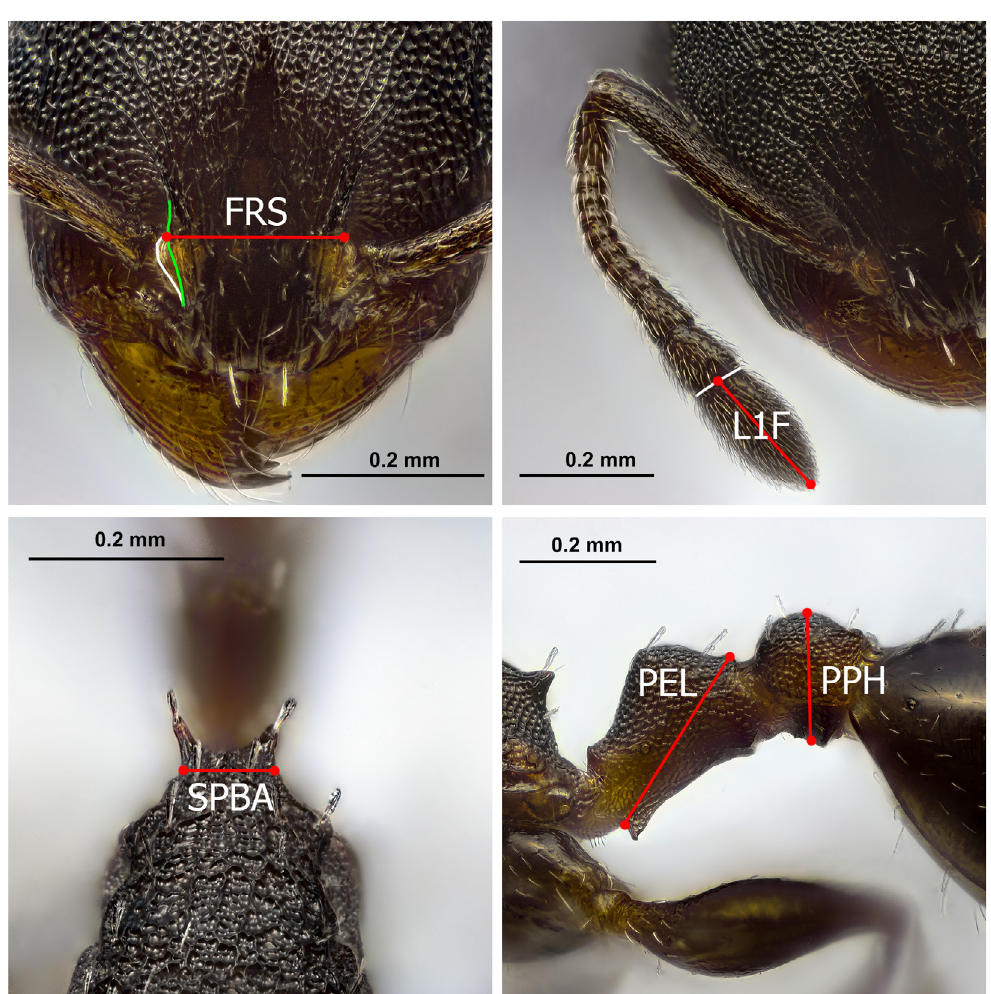
Fig 2 . Worker of T. convexus . A: frontal view showing how to measure FRS; the white line follows the profile of the dorsal lamellae and the green line follows the profile of the frontal carinae, with the measuring point starting at the intersection between both lines. B: frontal view showing how L1F is measured. C: detailed view of the mesosoma in dorso-frontal view, the position in which SPBA is measured. D: lateral view of the petiole and postpetiole, with the measuring points for PEL and